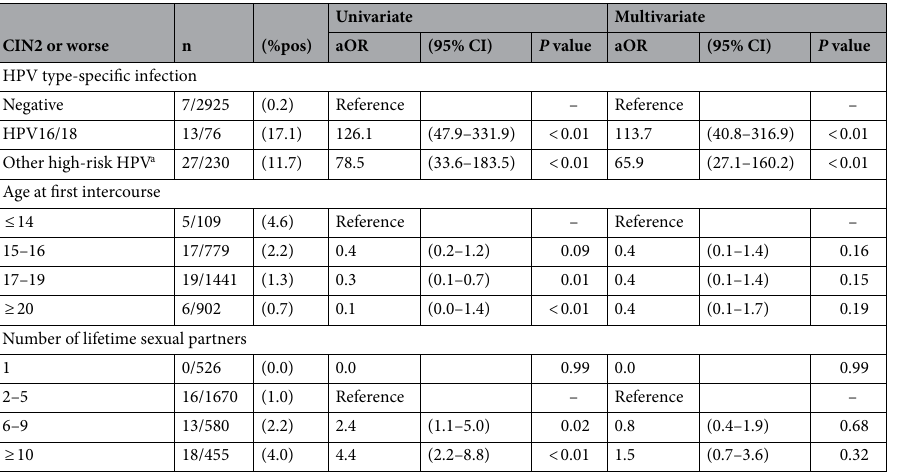
Table 5. Risk factors for high-grade cervical disease (CIN2 or worse). CIN cervical intraepithelial neoplasia, aOR adjusted odds ratio. Adjusted for age, smoking history, age at first intercourse, number of lifetime